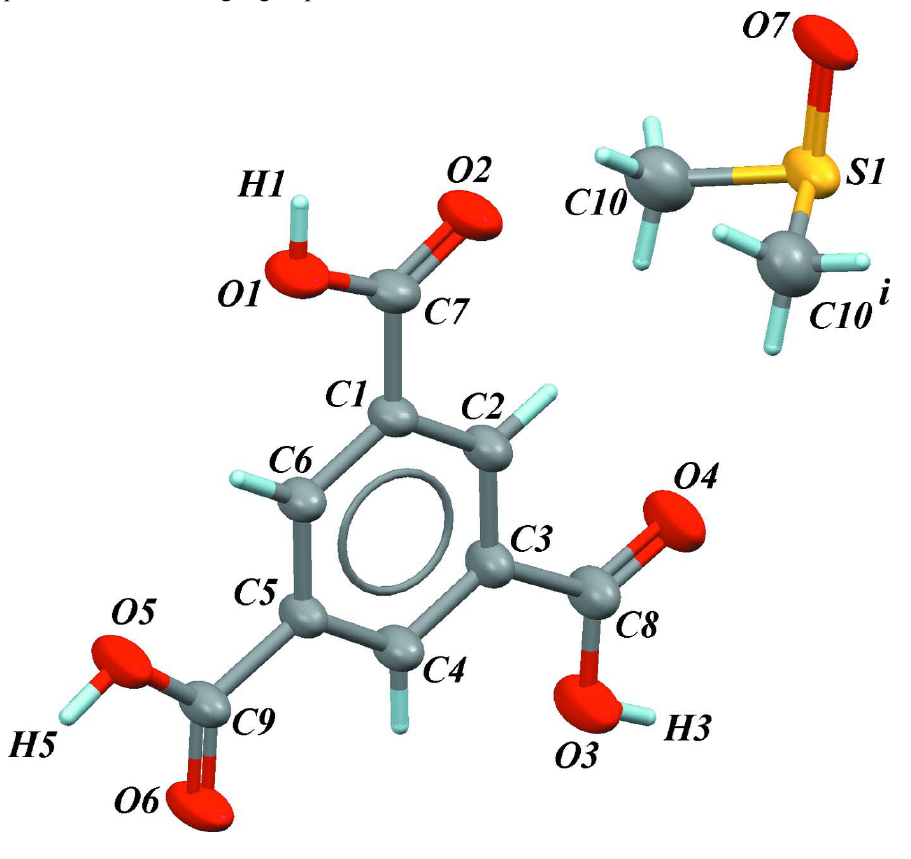
The structure of the title compound, with displacement ellipsoids for non-H atoms at the 50% probability level. Symmetry code: (i) x , 1/2 - y , z